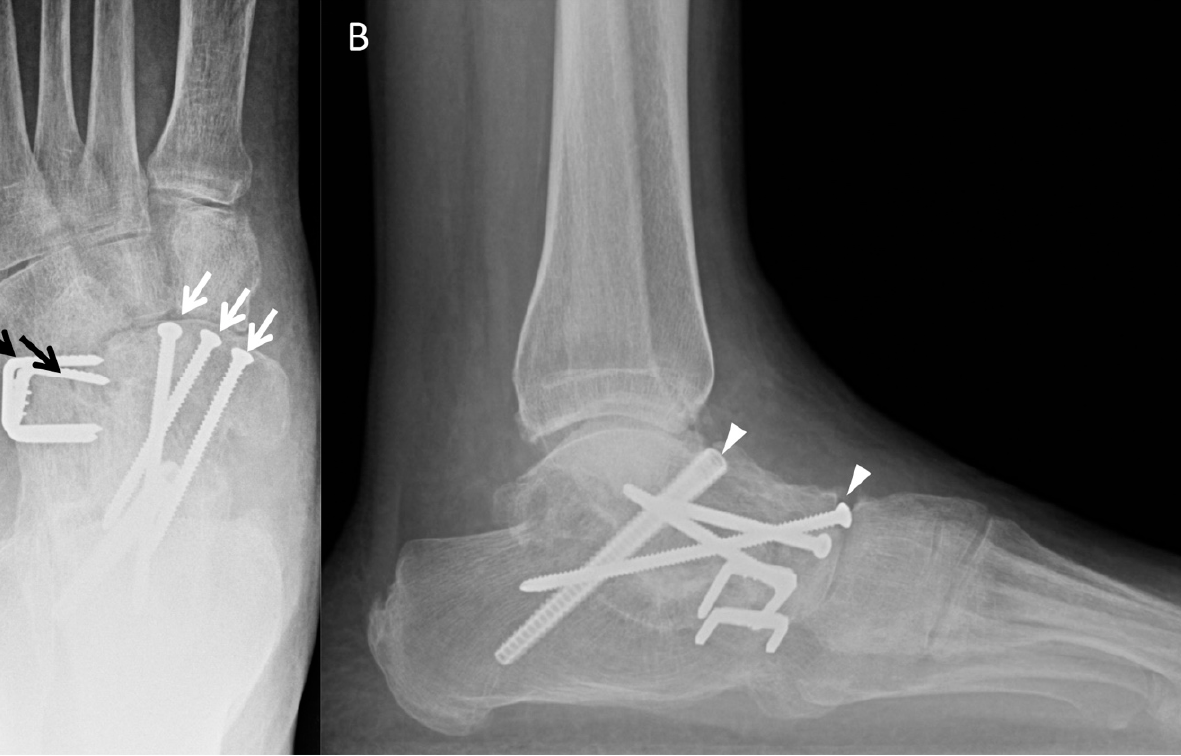
Figure 7. ( A ) AP and ( B ) lateral radiographs of the foot demonstrate hindfoot triple arthrodesis with hardware spanning the subtalar (arrow heads), talonavicular (white arrows) and calcaneocuboid joints (black arrows). The hardware is intact and there is mature ankylosis with decreased conspicu- ity of the joint